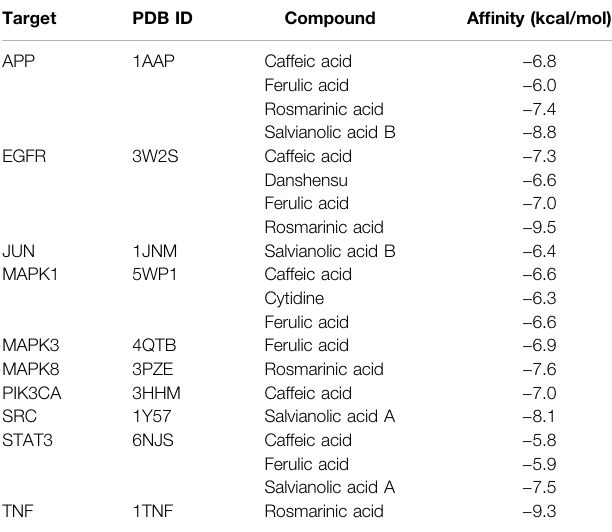
TABLE 1 | Basic information of docking results of 10 key targets with related compounds.